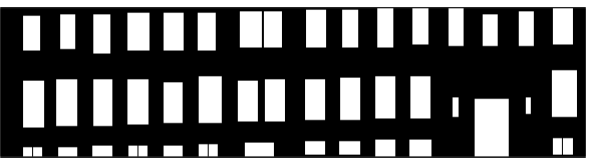
Figure 12. fitted rectangles to connected